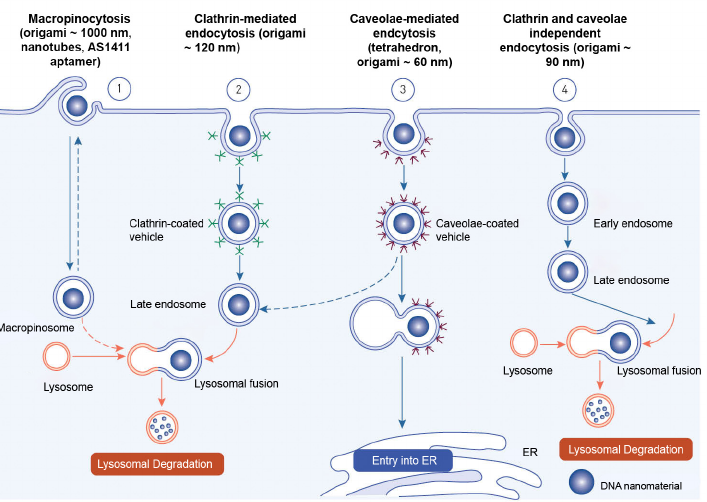
Figure 6. Endocytotic pathways involved in the internalization of DNA-based nanomaterials. Receptor-mediated endocytosis and macropinocytosis are the two primary methods of internalization of DNA-based nanomaterials. The activity of cargo molecules and other proteins controls clathrin-mediated and caveola-mediated endocytosis [249]. Free oli- gonucleotides, oligonucleotide conjugates, or oligonucleotide-carrying nanocarriers are internalized by endocytosis once they reach the cell surface [248]. The mechanism of endocytosis of DNA-based nanomaterials is not fully understood. The endocytosis process has only been examined for a relatively small variety of DNA nanostructures. The structure, chemical makeup, and cell type of the target cells must all be taken into account in studies of endocytosis and cell fate of each unique design. DNA nanostructures that have been absorbed typically end up being trapped and degraded in lysosomes. As a result, methods that enhance endolysosomal escape and encourage tar- geted drug delivery to the cytosol and nucleus are needed. These issues will also be re- solved by researching a nonendocytic route for DNA nanostructures [238]. Nanocarriers enter cells mostly through endocytosis and are sent to di ff erent orga- nelles inside the cell [250]. The loaded drug is typically released from the nanocarriers either extracellularly, in the microenvironment, or intracellularly into the tumor, primar- ily through cellular uptake via endocytosis [251]. 3.2.1. Delivery Mechanism of DNA Tetrahedrons It is known that the size of nanostructures has a signi fi cant impact on the type of endocytic route used. The TDNs are basically 7 to 20 nm in diameter [151]. By adjusting its orientation, TDN, in contrast to other DNA nanostructures, reduces electrostatic re- pulsive interactions and redistributes the TDNs’ uneven charge at the membrane surface, allowing it to actively penetrate the cell membrane using the vertex [252]. Tetrahedrons may be taken up through caveolin-dependent receptor-mediated endocytosis, according to a theory put out by Liang and colleagues. The receptor(s) in this uptake are not exactly established [5]. TDNs are carried into lysosomes by microtubules in a highly organized manner after entering a cell through membrane caveolin, preserving structural stability in the cell cytoplasm for up to 12 h [252]. While TDNs maintain their structural stability